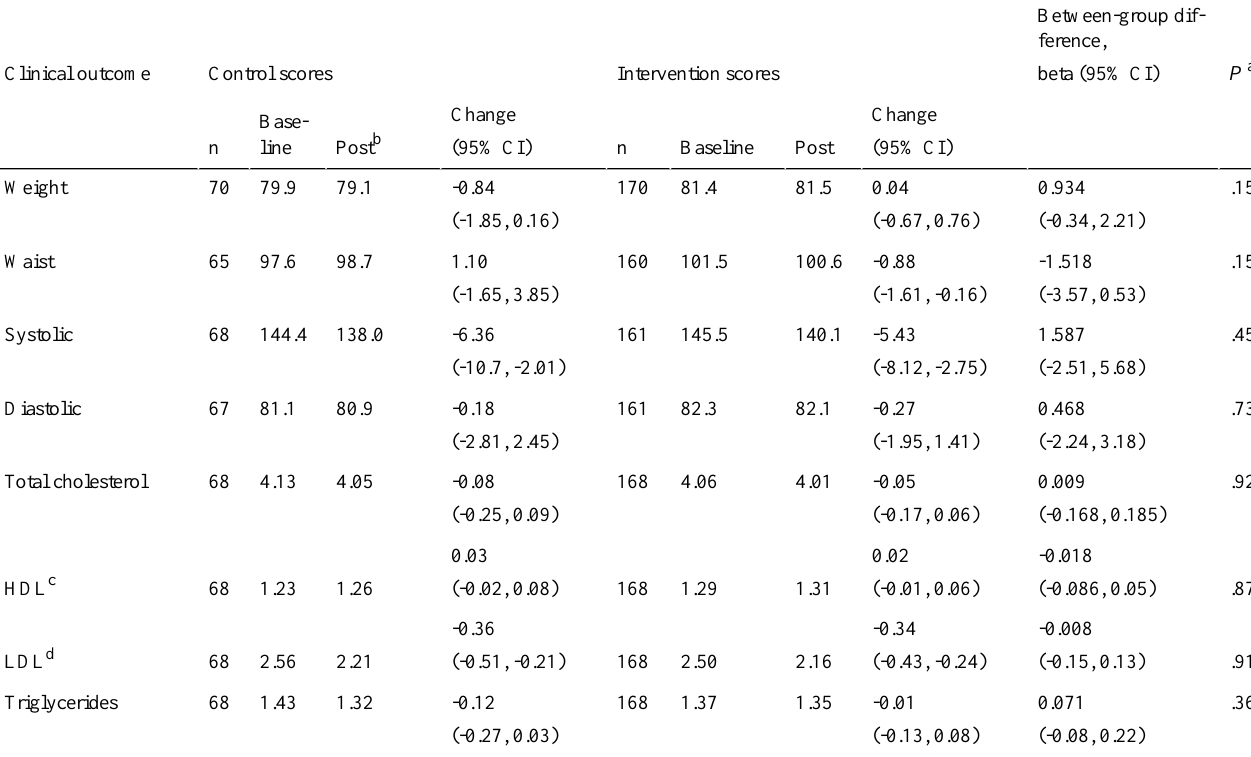
Table 4. Baseline, postintervention, and change scores in clinical outcomes for the heart disease group.